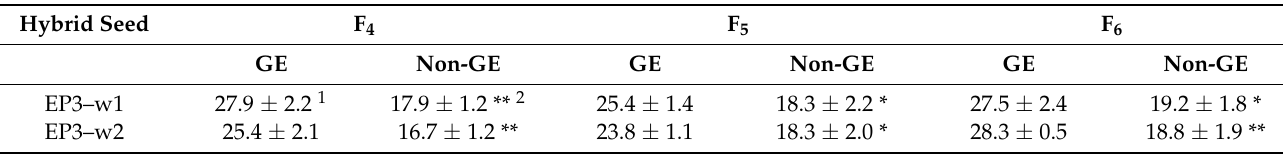
Table 1. Average dormancy ratios (%) of F 4 –F 6 seeds derived from hybrids between a genetically engineered (GE) rice line (EP3) and two wild rice populations (w1 or w2) after the 25-day soil-burial treatment. Hybrid Seed